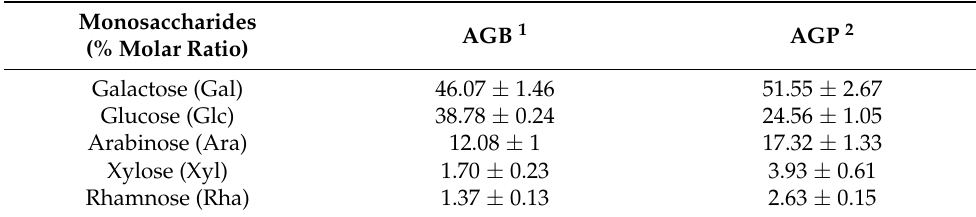
Table 3. Monosaccharide compositions determined by GC-EI/MS of sulfated glycoproteins AGB and AGP extracted from the green seaweed C. decorticatum